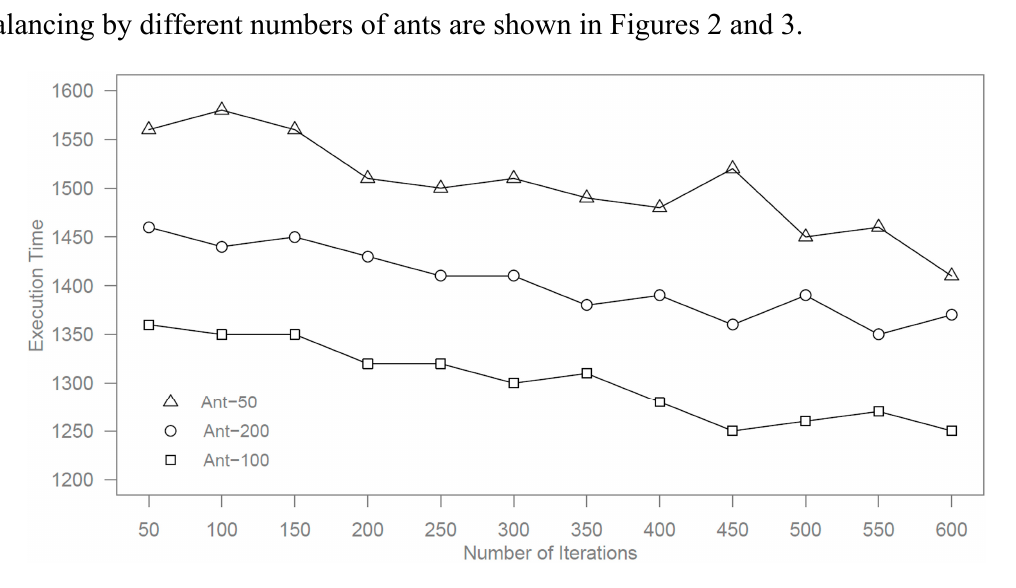
Figure 2. Execution time by different numbers of ants.